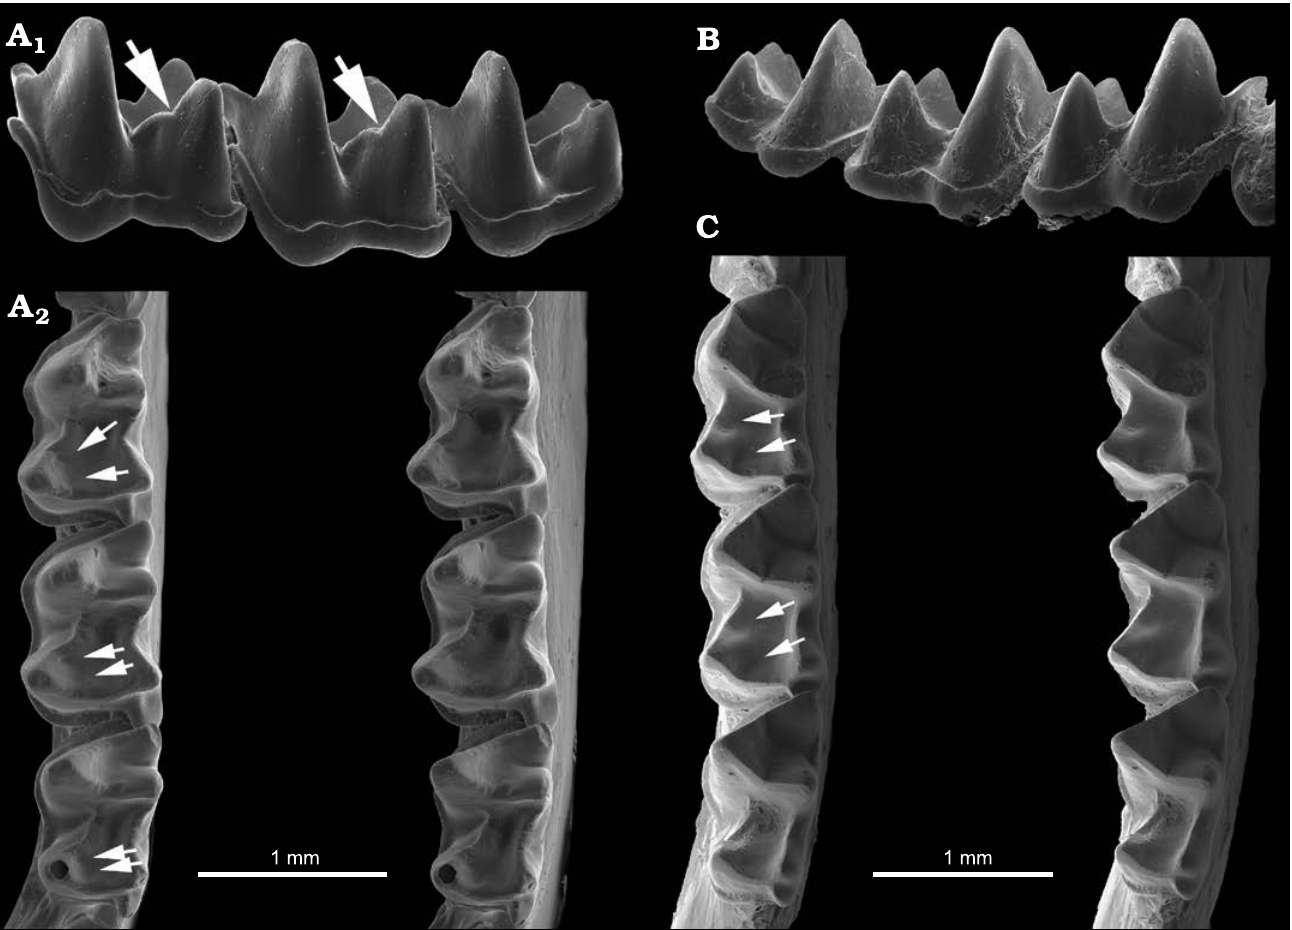
Fig. 13. Molars of Recent vespertilionid bats. A . Kerivoula argentata Tomes, 1861 (AMNH 89177) from Zambia. Left lower molars in anterolabial view (A 1 ) showing carnassiform notches (arrows) in the cristids obliqua of m1–m2, and in occlusal view (A 2 , stereopair) showing accessory troughs (arrows) in m1–m3. B , C . Phoniscus papuensis (Dobson, 1878b) (AMNH 157475) from Papua New Guinea. B . Right lower molars in anterolabial view showing deeply excavated cristids obliqua in m1-m3 but no within-crest carnassiform notches. C . Left lower molars in occlusal view (stereopair) showing well-de- veloped accessory troughs (arrows) in